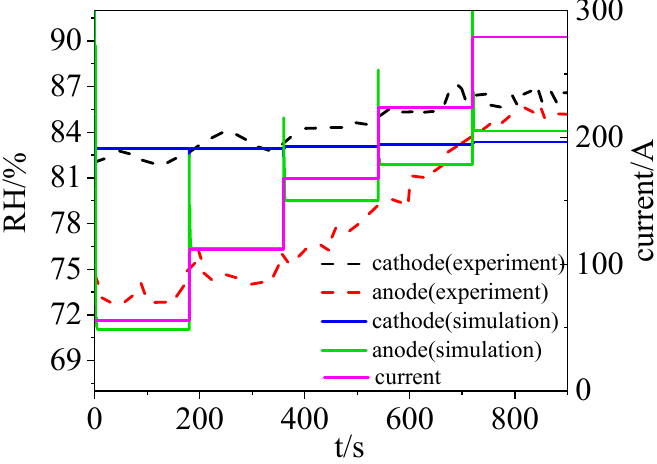
Figure 8. Comparison of experimental and simulation results for RH in